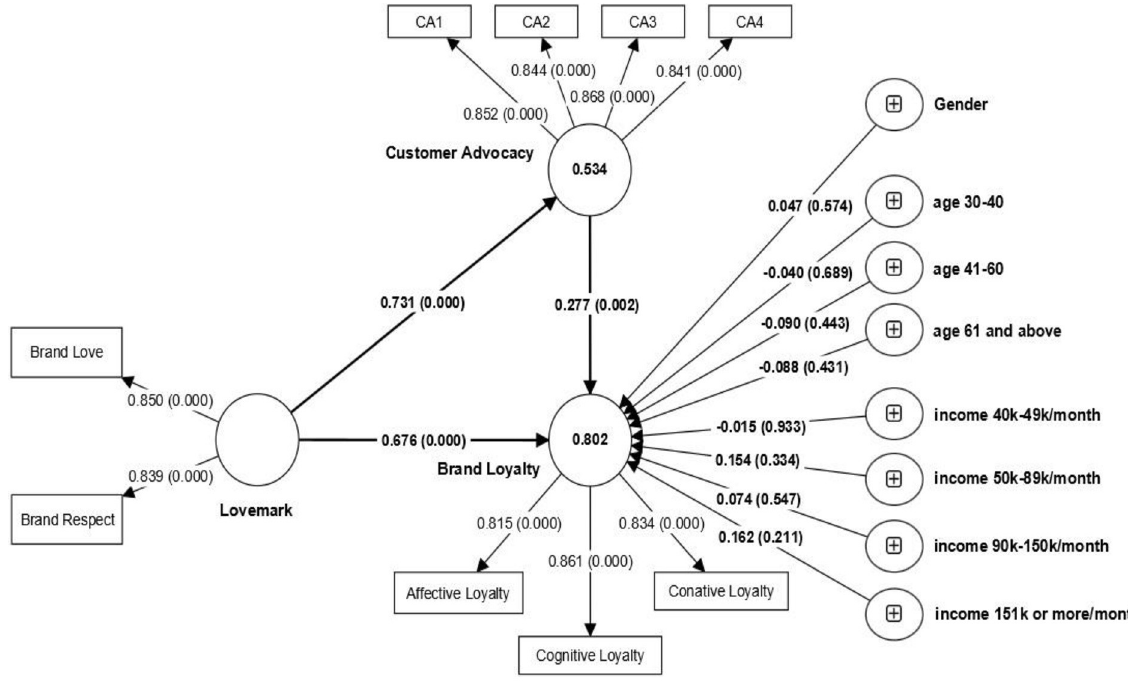
Fig 3. Structural model